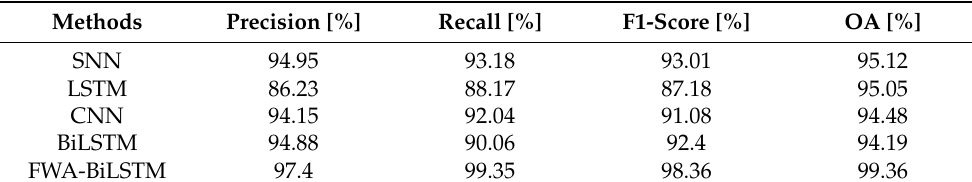
Table 6. Performance of classifier with attention layer on SVD dataset.